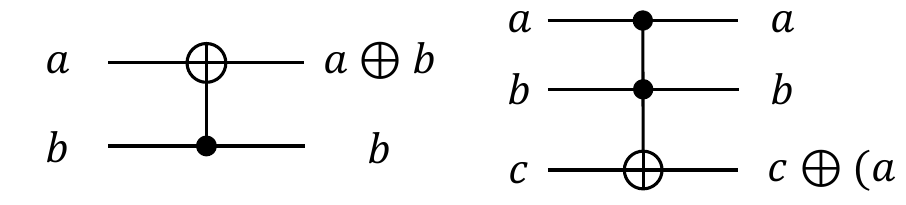
Figure 7. Circuit configuration of the (left) CNOT and (right) Toffoli gate.